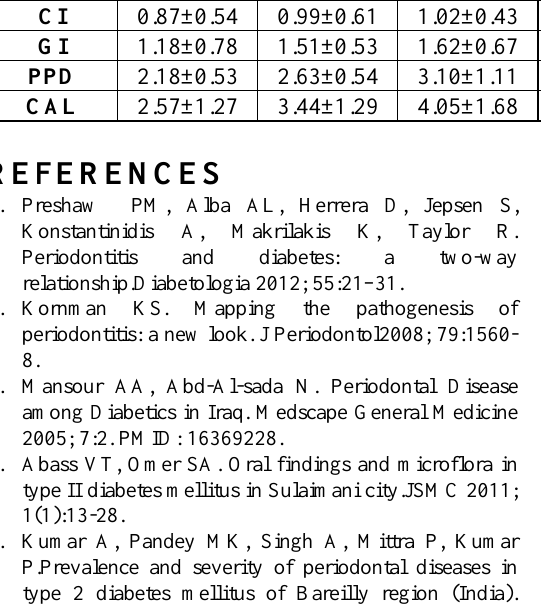
Table 2: Clinical periodontal parameters of type 2 diabetic patients according to arterial stiffness index (ASI) in comparison with controls